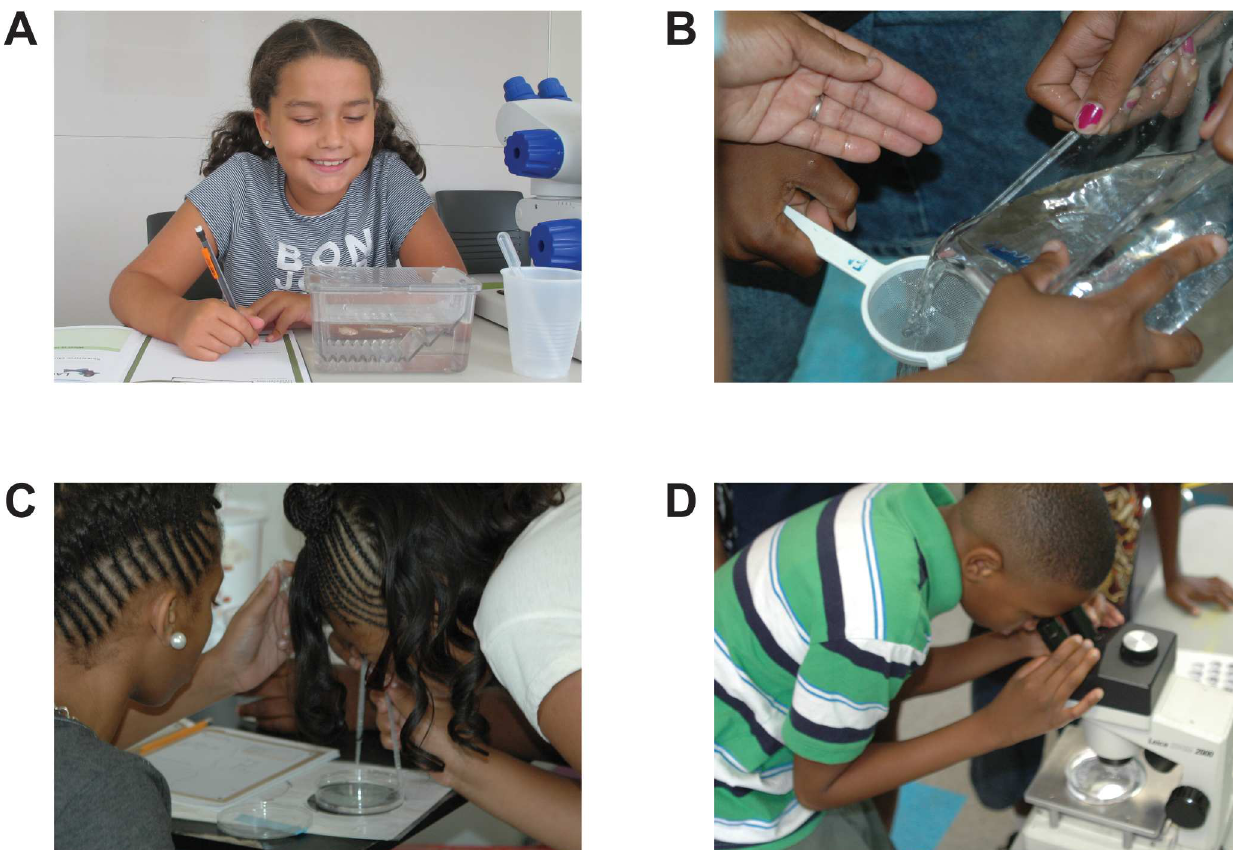
Fig 1. Activities and aims of Project BioEYES. (A) Buildinginvestigative skills by using a model organism to investigate, observe, and generate hypotheses. (B and C) Working in teams, students engagein hands-on activities using microscopes and simple lab tools to care for their zebrafish larvae. (D) Students are scientists. They make qualitativeobservations, collect quantitativedata, and engagein collaborative discourse using appropriate scientific vocabulary. Throughout this process, students analyze and interpret data, draw conclusions, and communicate results.